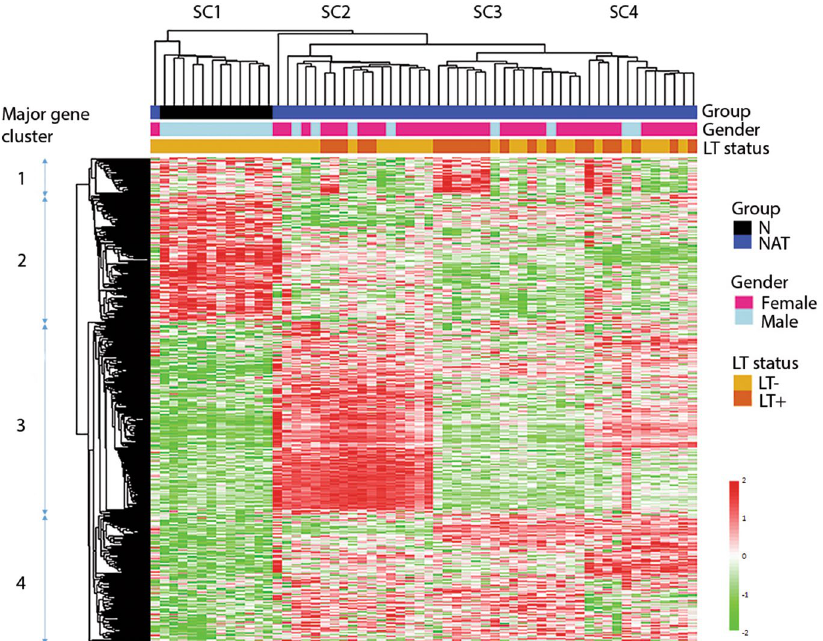
Figure 5. Dendrogram and clusters generated using 646 differentially expressed genes of NAT vs N. The heat map was generated based on 58 samples (46 NAT and 12 N). The annotation bars (above heat map) show sample clusters (SC1-SC4) and gender and the LT status of samples. The bar on the left side demonstrates the range for scaled and centered log2 expression. Red means higher expression and green means lower expression. Four major gene clusters are